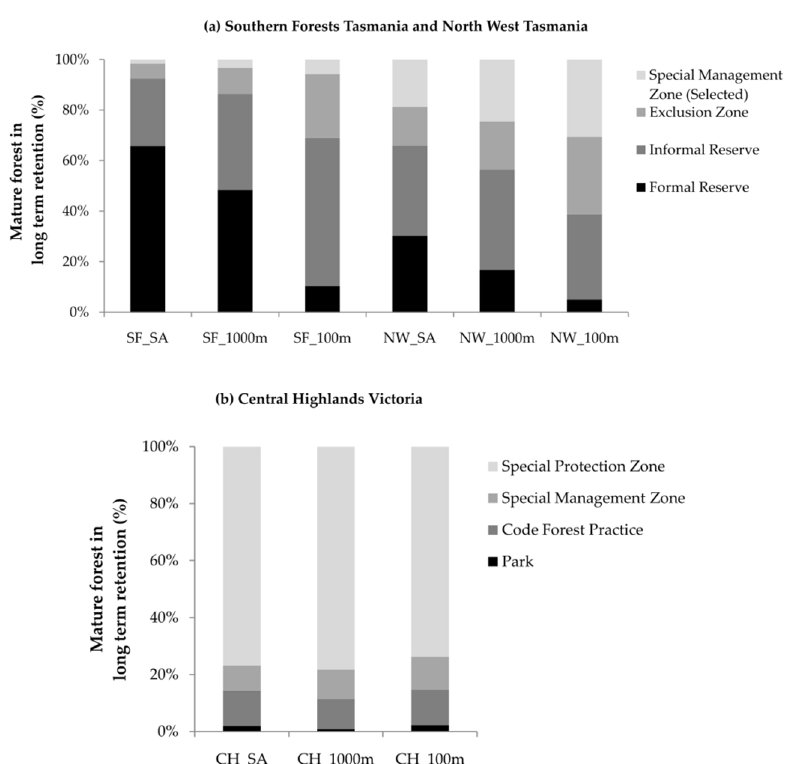
Figure 7. Relative proportion of structurally mature forest in four types of long ‐ term retention at three spatial scales in ( a ) Tasmania and ( b ) Victoria. Statistics were calculated for (i) the study area (_SA); (ii) 1000 m buffers around each harvested patch (_1000m), i.e., landscape context scale; and (iii) 100 m buffers around each harvested patch (_100m), i.e., forest influence scale. Southern Forests Tasmania (SF); North West Tasmania (NW); Central Highlands Victoria (CH). Tenure types included in long ‐ term retention categories are detailed in Appendix A.